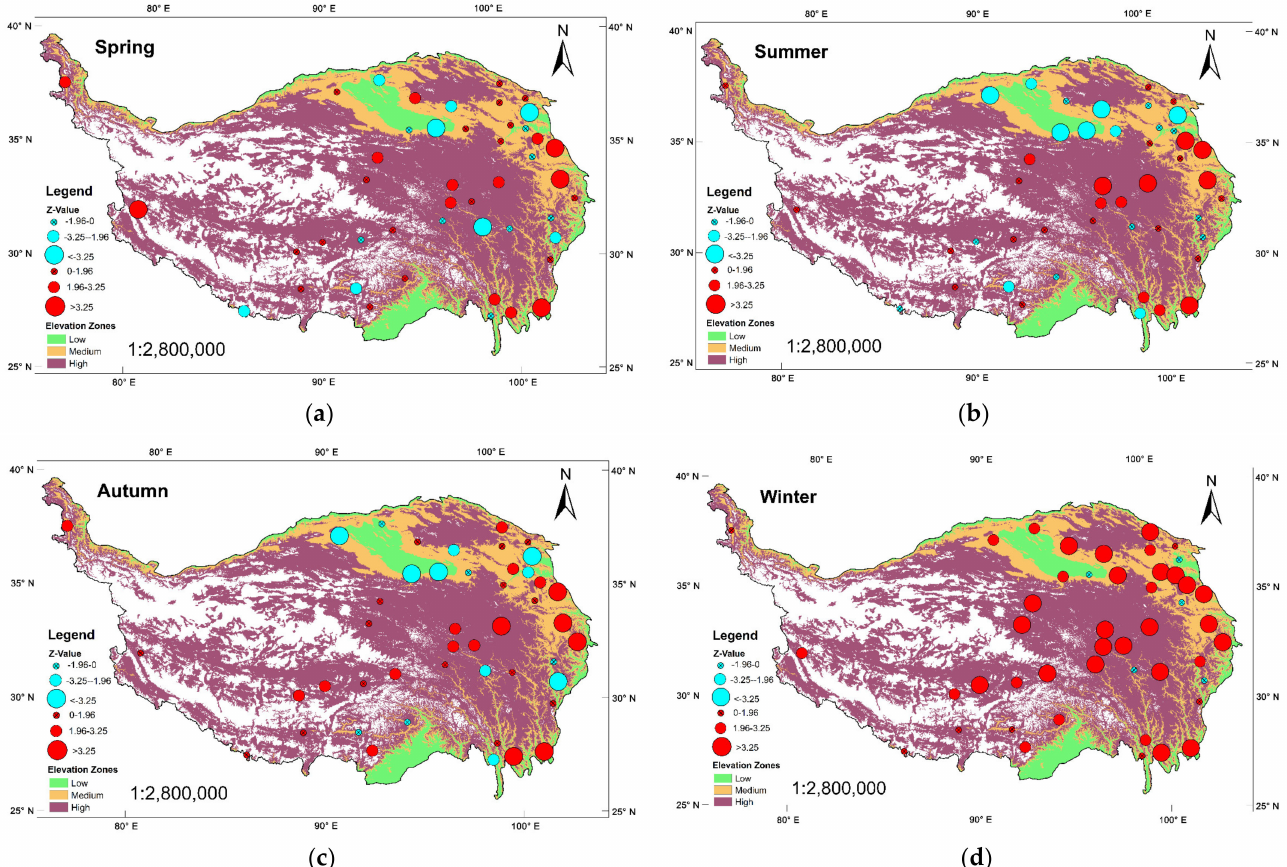
Figure 6. The distribution of the statistical Z-value from the MK test of four seasons ( a – d ) at each station of QTP from 1961 to 2017. At α = 0.05 significance level, if | Z | > 1.96, the ET 0 changes significantly. At α = 0.001 significance level, if | Z | > 3.25, the ET 0 change is extremely significant. The red bubble represents the increasing trend, the blue represents the decreasing trend, and the larger the bubble is, the more significant the change trend